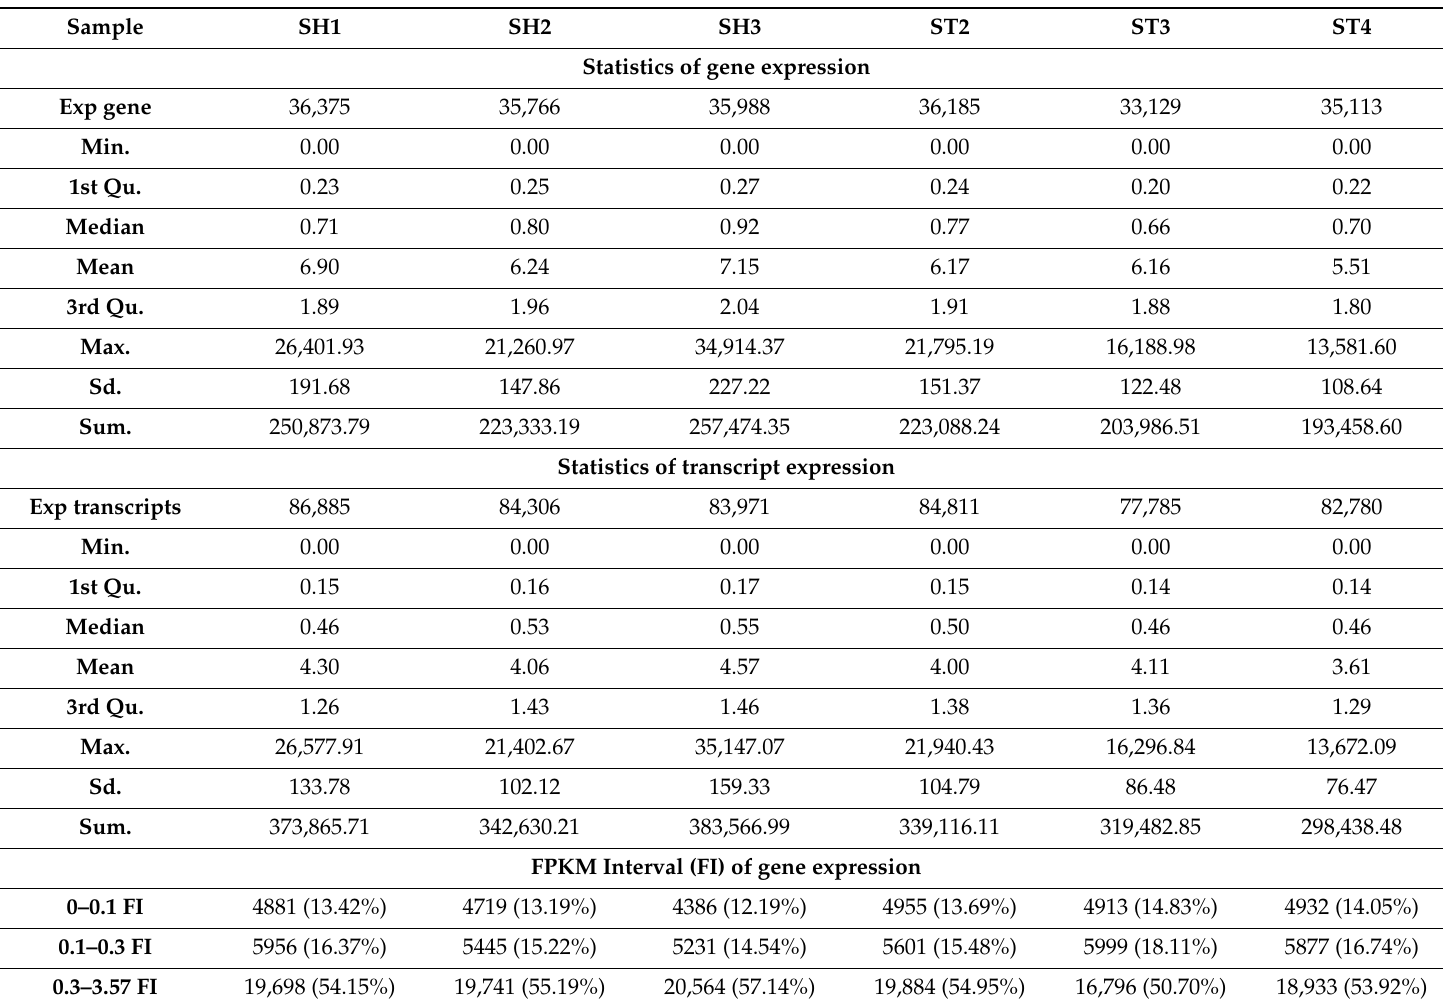
Table 2. Summary of statistics of gene / transcript expression between the skeletal muscles of sham and stroke